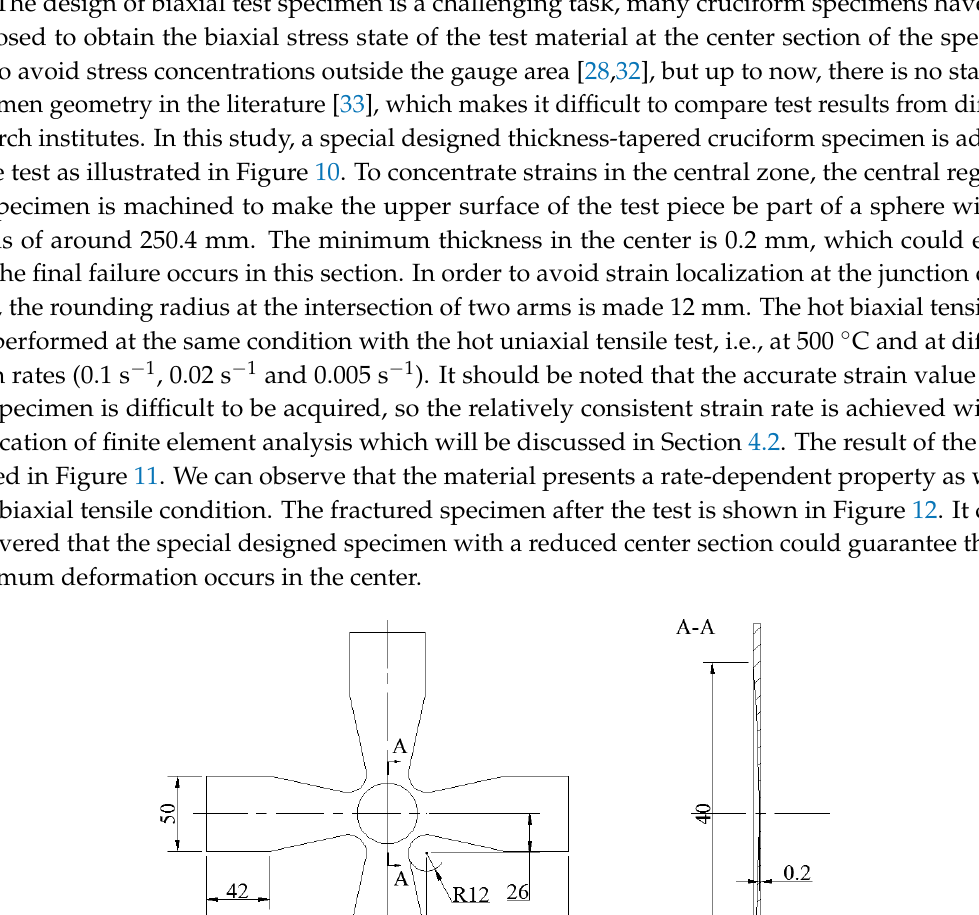
Figure 9 Biaxial tensile test machine. Figure 9. Biaxial tensile test machine.